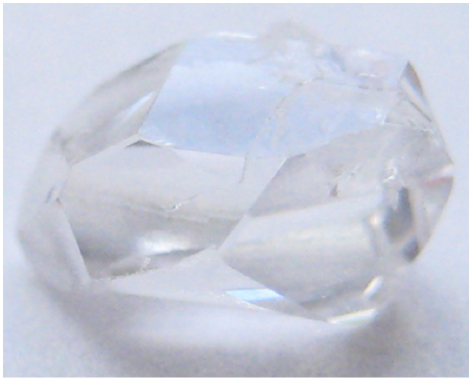
Figure 34. Highly faceted, optically clear, as-grown Yb:Lu 2 O 3 single crystal grown at 700 °C with a 30 degree thermal gradient. Crystal dimensions are 6 × 6 × 4 mm 3 .